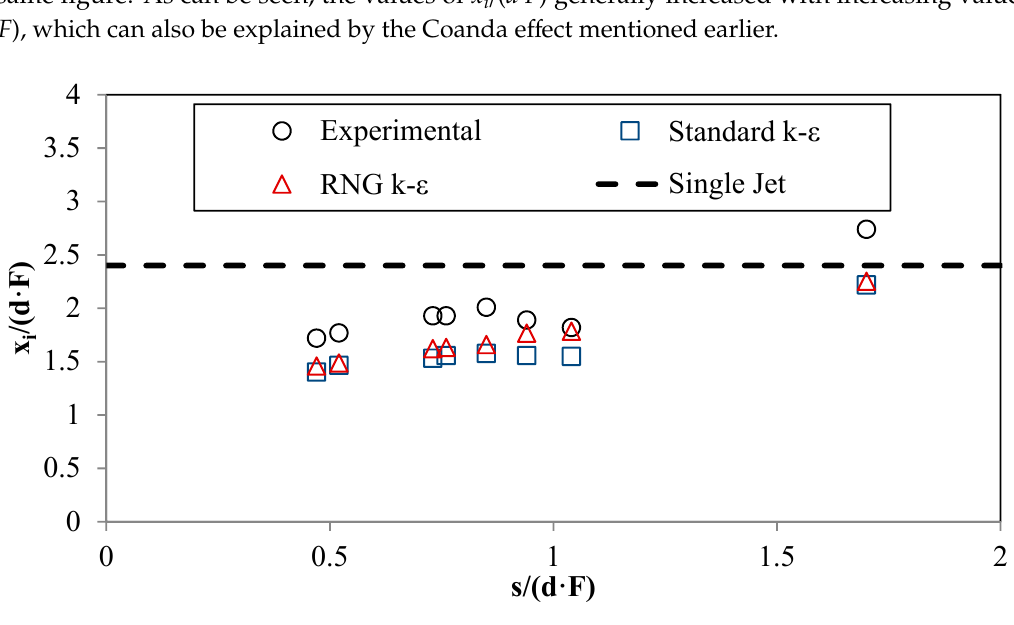
Figure 5. Experimental and numerical results of x i /( d · F ). Table 3. Error indices of the numerical models for x i /( d · F ).